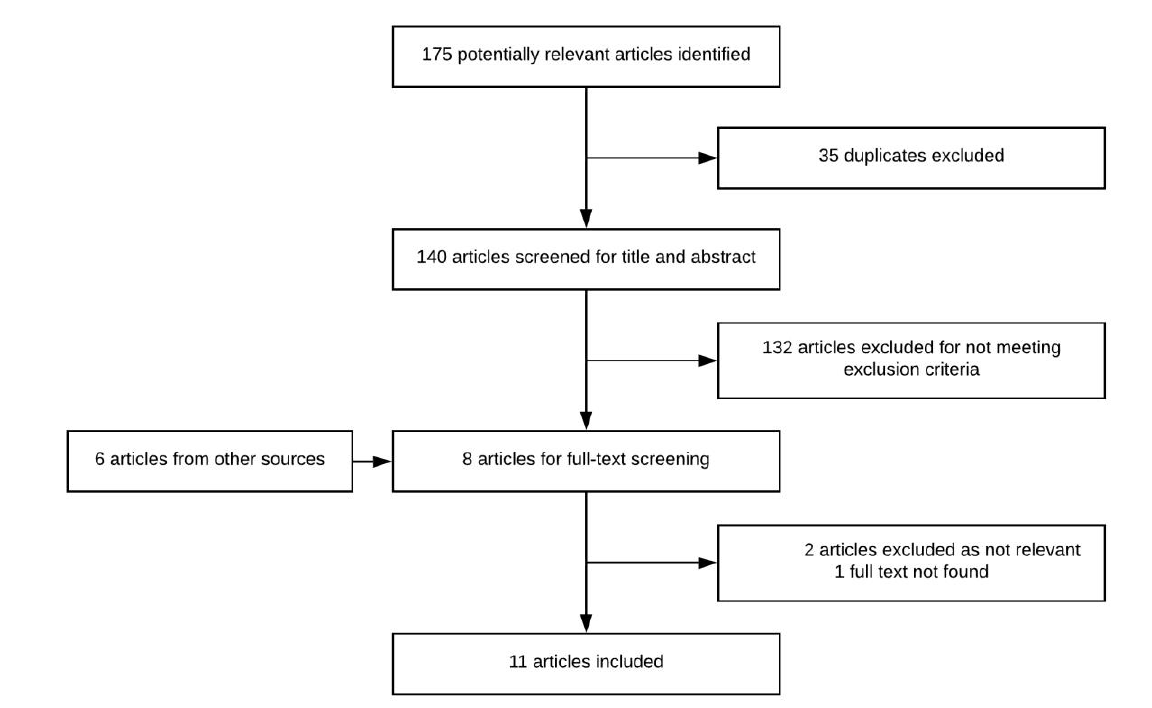
Figure 1. Screening and selection of